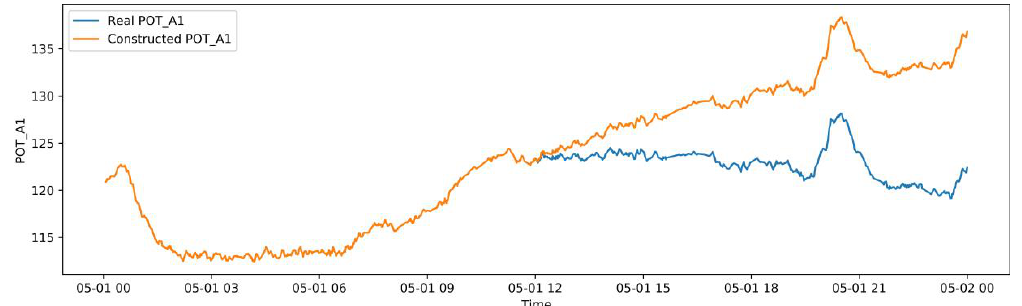
Figure 14. Real-time monitoring of variables in a normal case: ( a ) LOT; ( b ) POT_A1; ( c ) POT_A2; ( d ) MNDT; ( e ) MDT; ( f ) MBT_1; ( g ) MBT_2; ( h ) MBT_3.